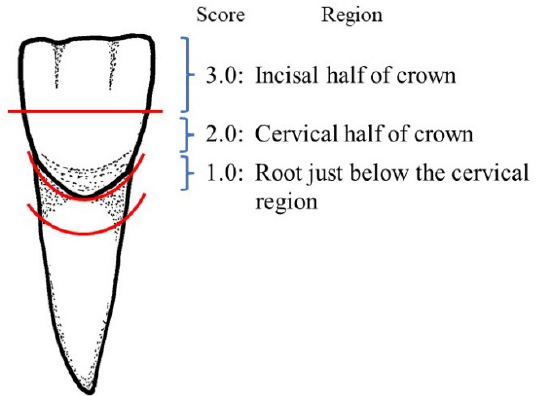
Figure 1. Score of Pink Teeth Color values, color swatches, and representative photographs. The degree of discoloration was visually classified into 3 scores as follows: faint pink, 1.0; pink, 2.0; and dark pink, 3.0.